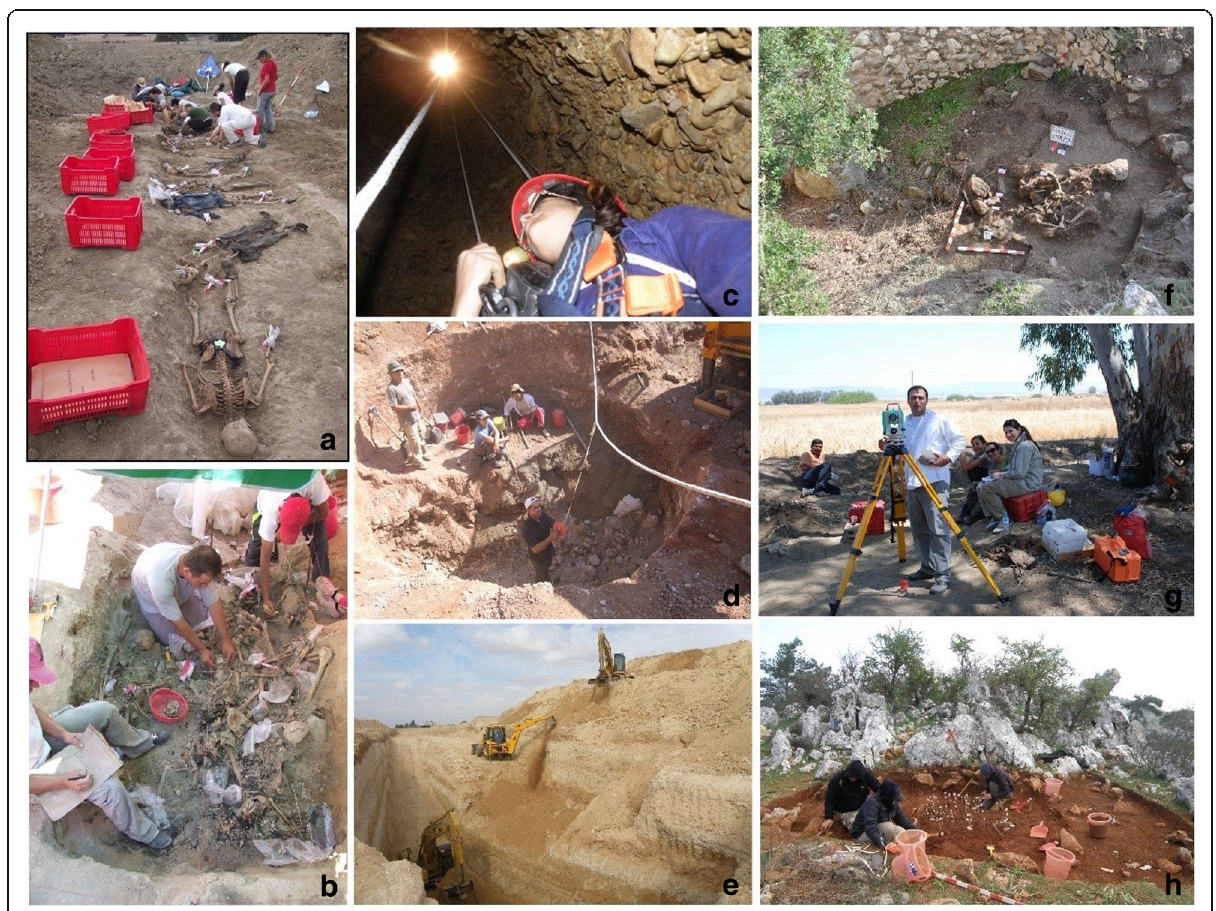
Fig. 2 From top to bottom: ( a ) a mass grave exhumation with the EAAF in 2007, ( b ) an exhumation of commingled remains, ( c ) an archaeologist entering a well, ( d ) an exhumation inside a well, ( e ) creating terraces during a deep well excavation, ( f ) an exhumation inside a kiln, ( g ) recording a site with total station, ( h ) exhumation of a shallow burial on a